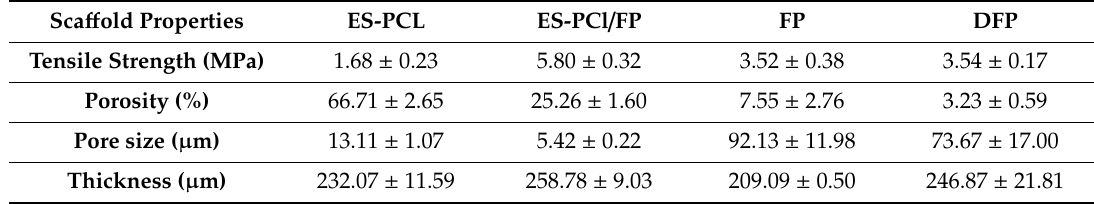
Table 1. Porosity percentage and thickness of sca ff